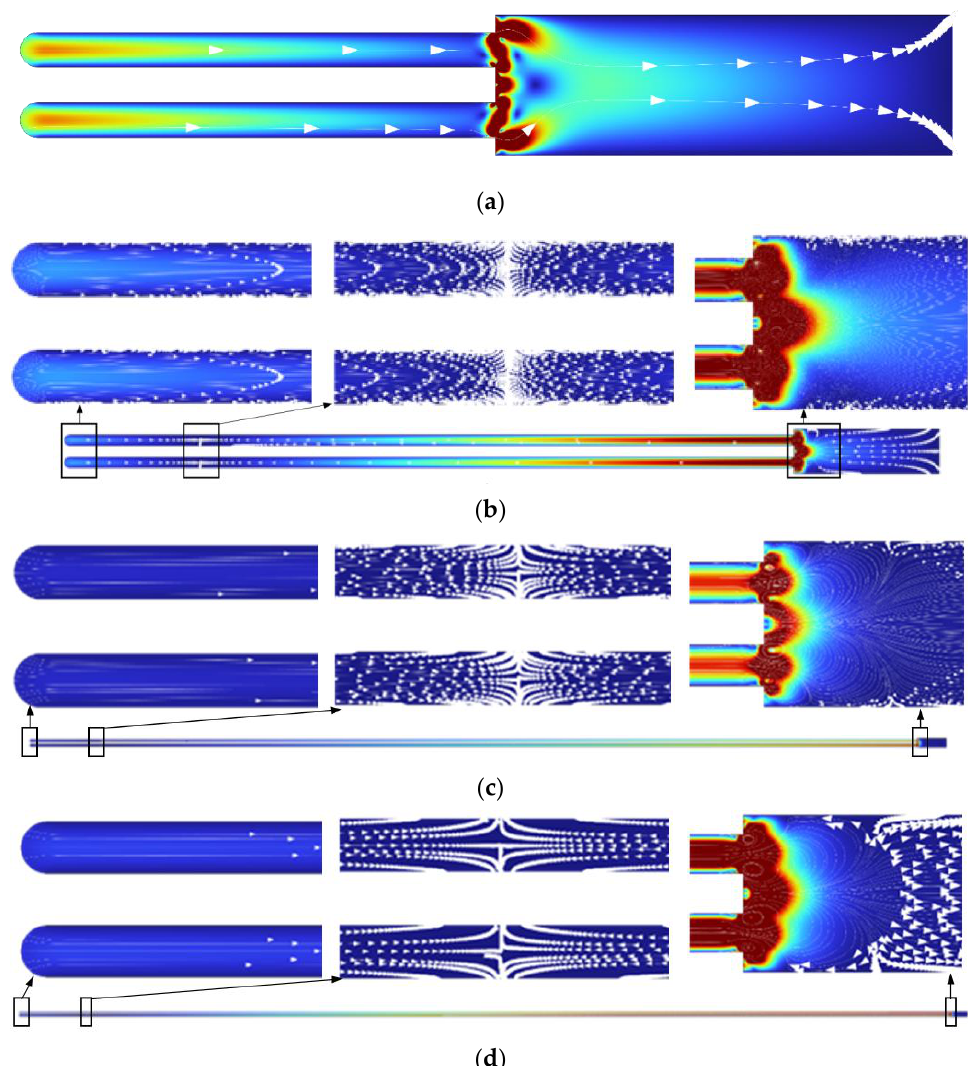
Figure 5. Fluid flow velocity contour at resonant frequency excitation of 40 kHz at different pore depths: ( a ) 1 µm; ( b ) 5 µm; ( c ) 30 µm; ( d ) 55 µm.